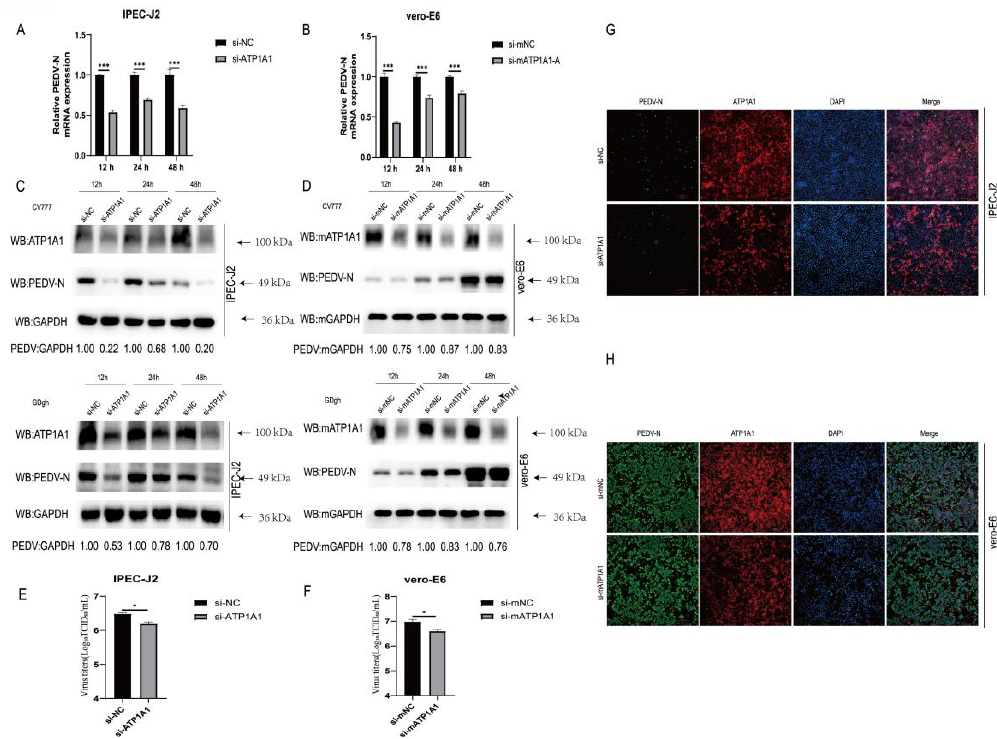
Figure 3. Knockdown of endogenous ATP1A1 expression suppresses PEDV infection. ( A , B ) Knock- down of endogenous ATP1A1 significantly suppresses PEDV RNA abundance. Transfected with siRNAs against ATP1A1 or siRNA-NC for 24 h, cells were collected at 12, 24 and 48 h after PEDV (0.1 MOI) infection of target cells for quantitative PCR assay. Data represent means ± SD from three independent experiments. *, p < 0.05; **, p < 0.01; ***, p < 0.001; ****, p < 0.0001. ( C , D ) Knockdown of endogenous ATP1A1 reduces in PEDV N protein expression. After knocking down with the expres- sion of ATP1A1 for 24 h, target cells were infected with PEDV (CV777-G1 or GDgh-G2) at 0.1 MOI and collected and lysed at different time points for Western blot analysis. ( E , F ) Knockdown of en- dogenous ATP1A1 suppresses PEDV viral titers. PEDV at 0.1 MOI infected cells with low ATP1A1 expression for 24 h, and cell supernatants were extracted for TCID 50 assay. Data represent means ± SD from three independent experiments. *, p < 0.05. ( G , H ) Knockdown of endogenous ATP1A1 re- duces PEDV infection. Cells were transfected with siRNAs for 24 h, and then PEDV (0.1 MOI) in- fected for 24 h. The cells were stained with anti-ATP1A1 mAb (red) and anti-PEDV-N mAb (green). Staining of cell nuclei using DAPI (blue) staining solution. The processed samples were photo- graphed and analyzed using fluorescence microscopy. Scale bars, 200 μm.